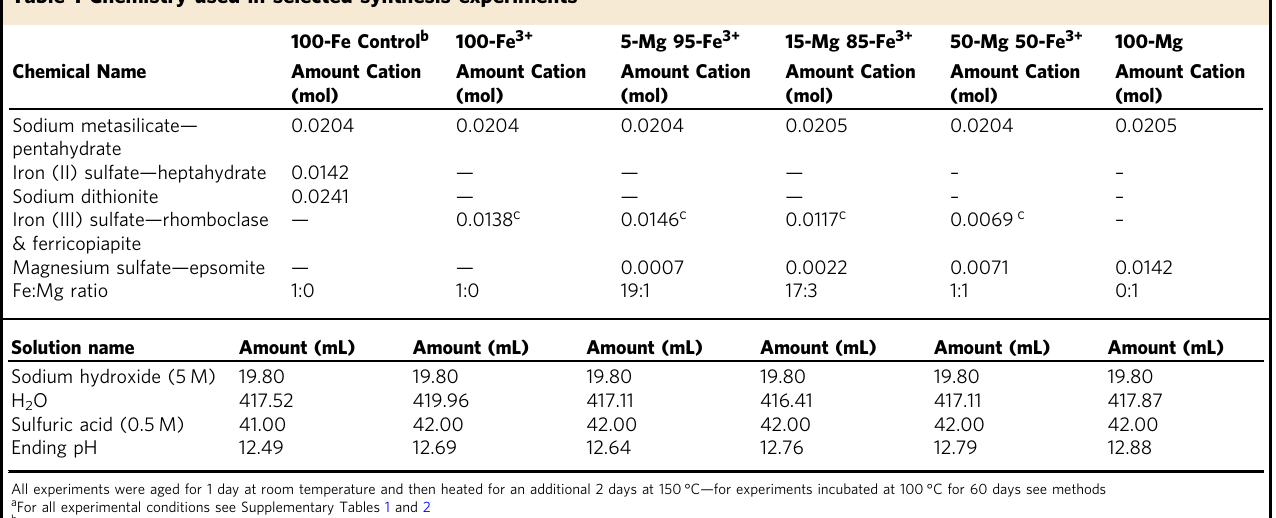
Supplementary Table 6. Most of the conducted experiments (e.g.,